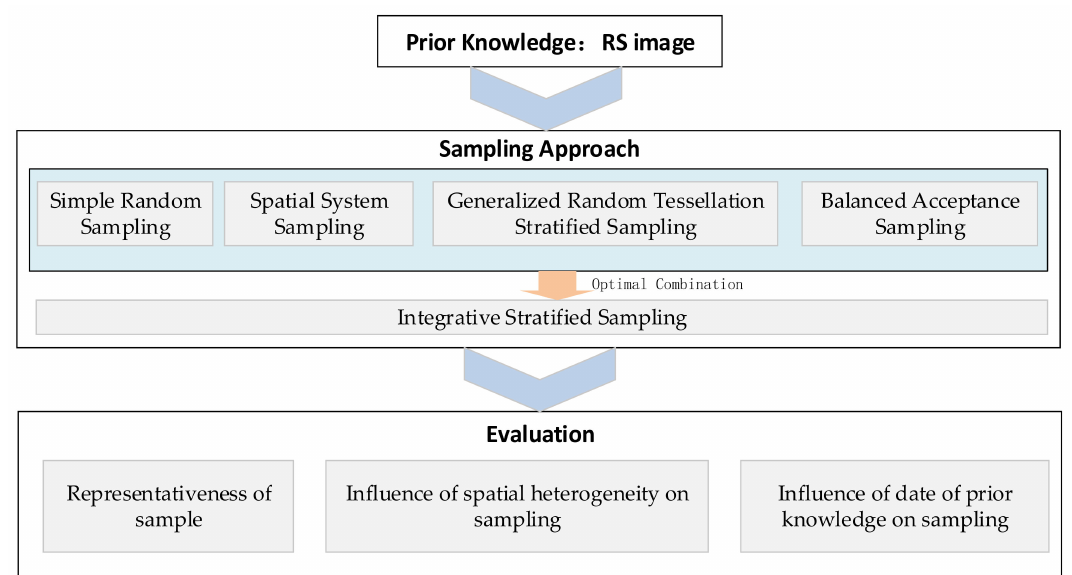
Figure 2. Flowchart of the approach used in this